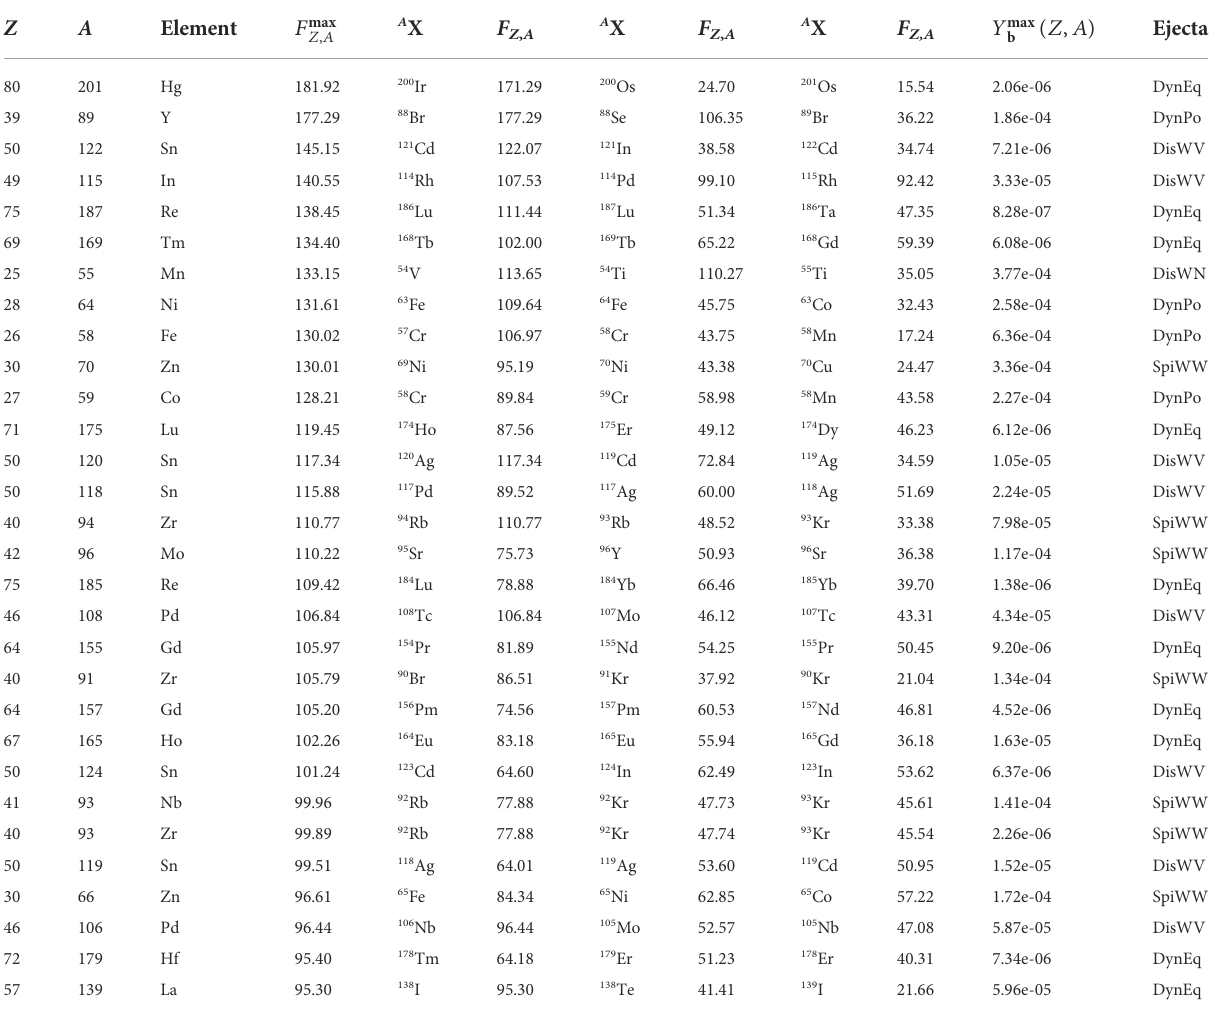
TABLE 4 30 most sensitive isotopes with the relative maximum local sensitivity ( F max Z , A ) and the top three A X (n, γ ) reactions with the strongest local sensitivities ( F Z , A ) for the considered ejecta trajectory. For each isotope, the trajectory was selected as the one predicting the maximum abundance Y max b ( Z , A ) for the baseline